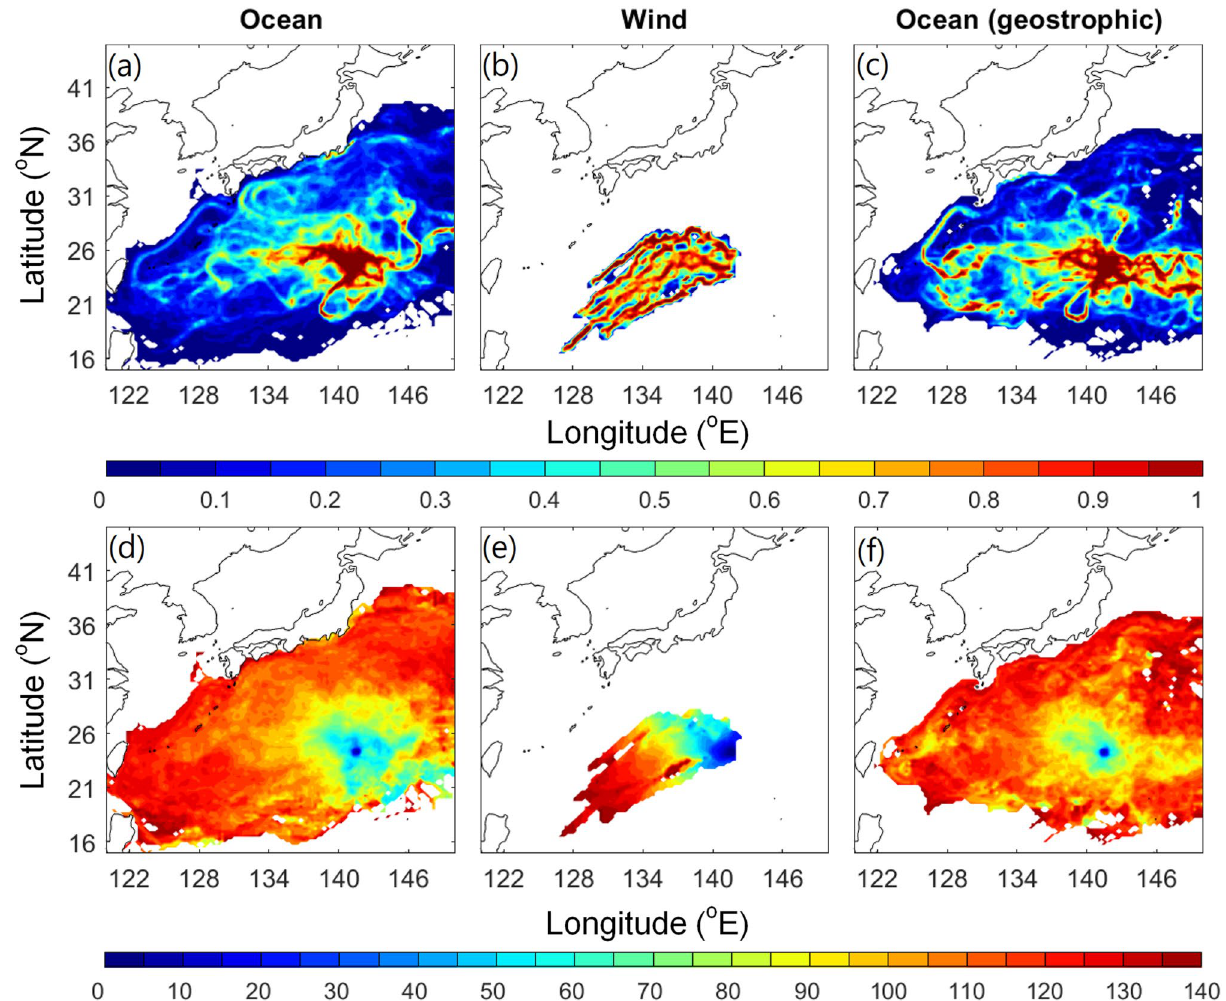
Figure 8. ( a – c ) Normalized visitation frequency and ( d – f ) time-evolving distribution (days) based on 28 years (1993–2020) daily hindcast with (a, d) 0% windage and ocean current; ( b , e ) 2% windage without ocean current; ( c , f ) 0% windage and geostrophic ocean current. Figure is created using MATLAB R2011b (http:// www. mathw orks.